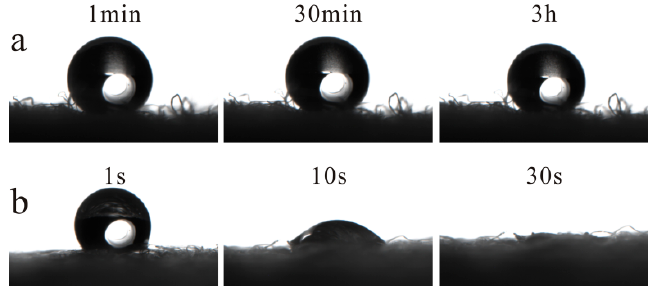
Figure 13. The contact angles of paper at different temperature: ( a ) T (55 °C) > LCST; ( b ) T (15 °C) < LCST.